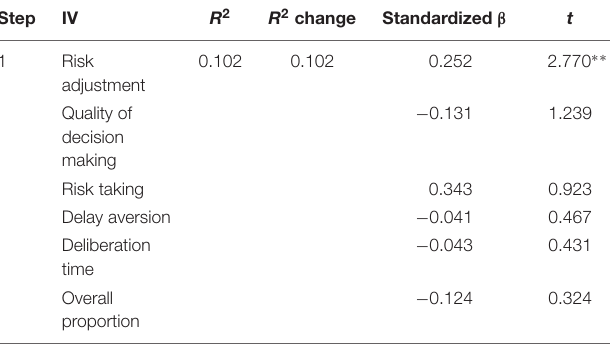
TABLE 9 | Hierarchical regressions predicting CGT variables among bully total.